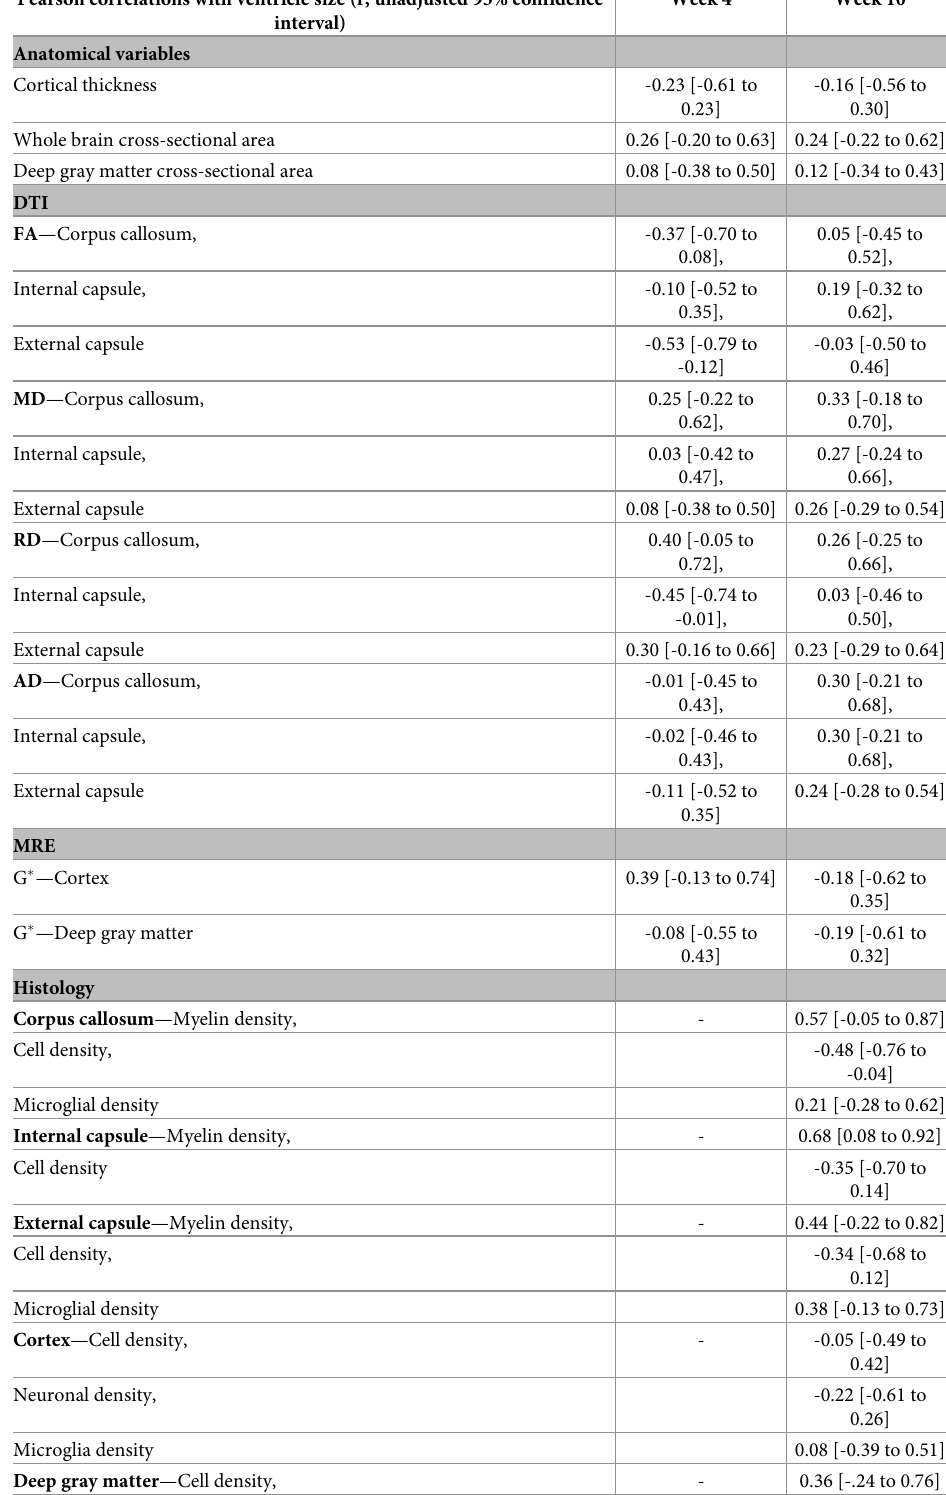
Table 2. Estimates of the correlations with ventricle size. Pearson correlations with ventricle size (r, unadjusted 95% confidence